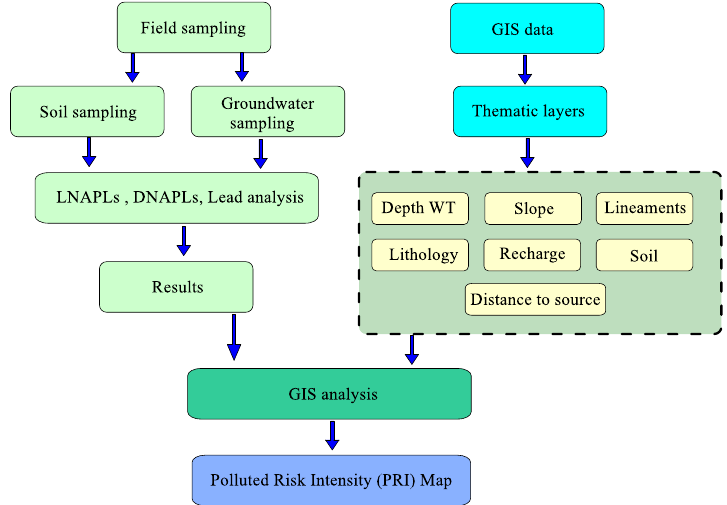
Figure 5. Overall flowchart of the methodology of the present study.